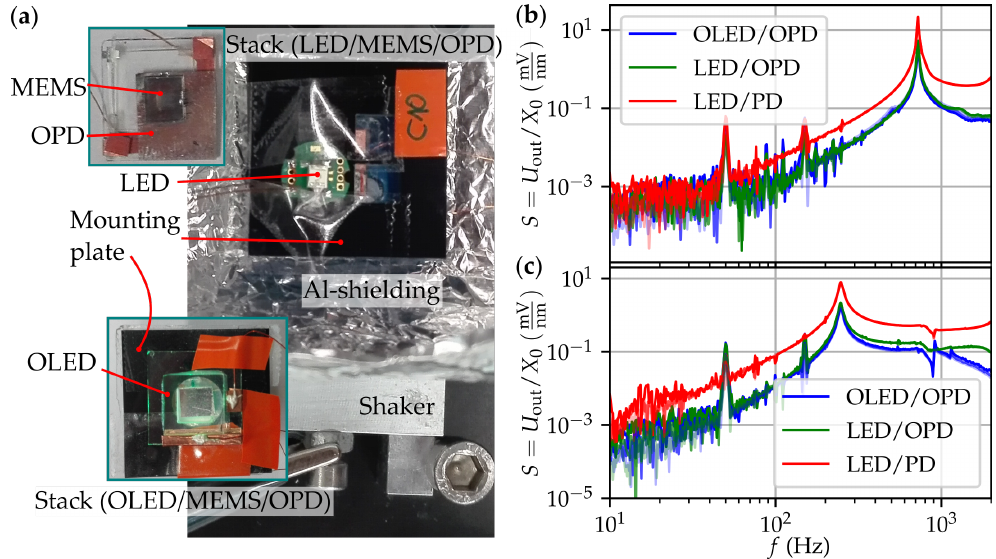
Figure 2. ( a ) Sensor components and stacks comprising (O)LED, MEMS and OPD. The MEMS chips were glued onto the OPDs such that the sensitive area and shutter area overlap. The (O)LEDs are fixed on top of the MEMS/OPD stack with a mounting plate in between to prevent electrodes from touching. The stacks were first characterised with the piezoelectric shaker. ( b ) results of MEMS with f 0 = 620Hz in terms of the sensitivity S . ( c ) results of a MEMS with f 0 = 250Hz. Each optoelectronics pairing was measured for three differend values of X 0 accounted for by opacity of the